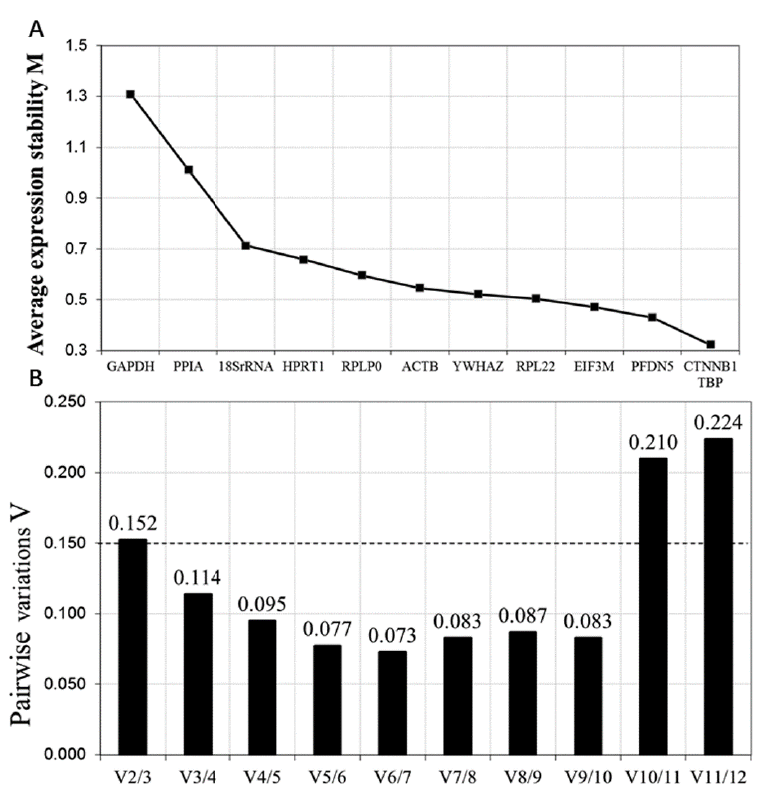
Figure 1. geNorm analysis of selected 12 reference genes. ( A ) The average expression stability measure of candidate reference genes. ( B ) The pairwise variation in 12 reference genes for the determination of the number of candidate reference genes.